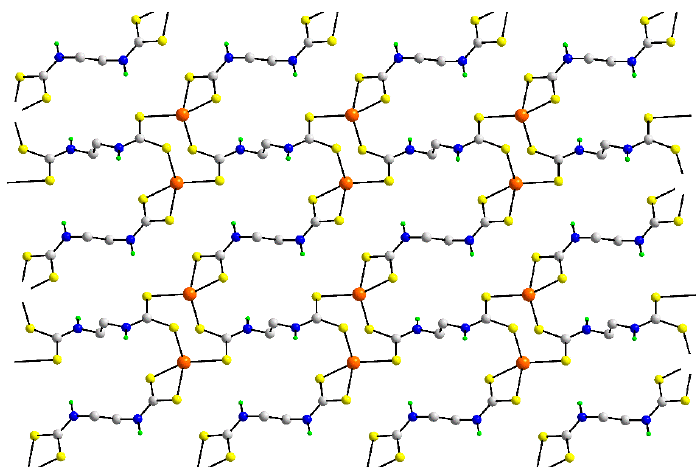
Figure 13. A plan view of the flat, supramolecular layer formed by [Zn(L 18 )] n in the crystal of 45 .